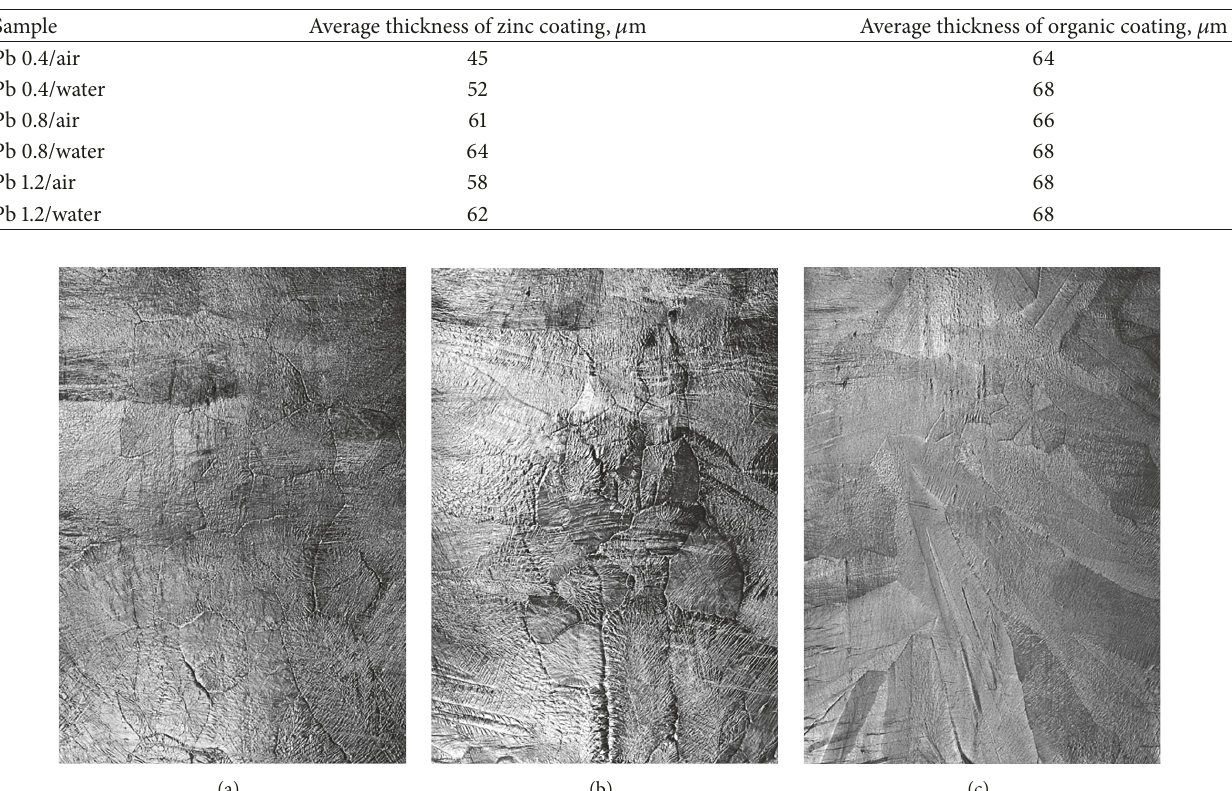
Table 2: Thickness of zinc and organic coatings.